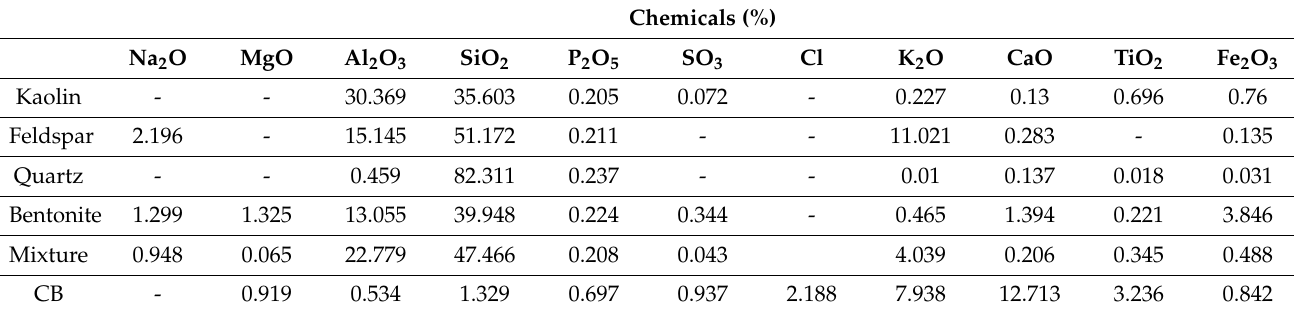
Table 1. The chemical composition (oxides) of the raw